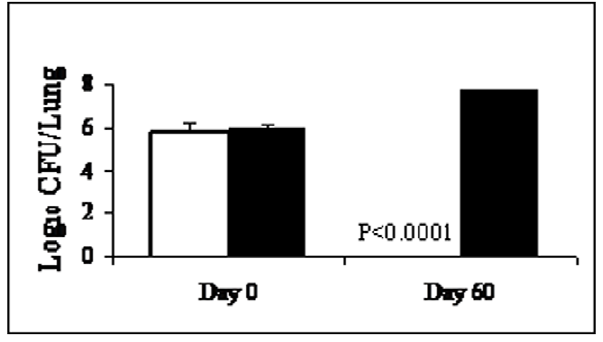
Figure 1. B.pertussis causes persistent respiratory infection in SCID mice. Two groups (BALB/c, white columns; and SCID, black columns) of 5 mice were infected i.n. with , 1 6 10 6 B. pertussis BPSM and sacrificed 3 h (Day 0) or eight weeks later (Day 60) for CFU counts in the lungs. The results are expressed as means of log CFU values per lung ( 6 standard error) and are representative of three independent experiments.